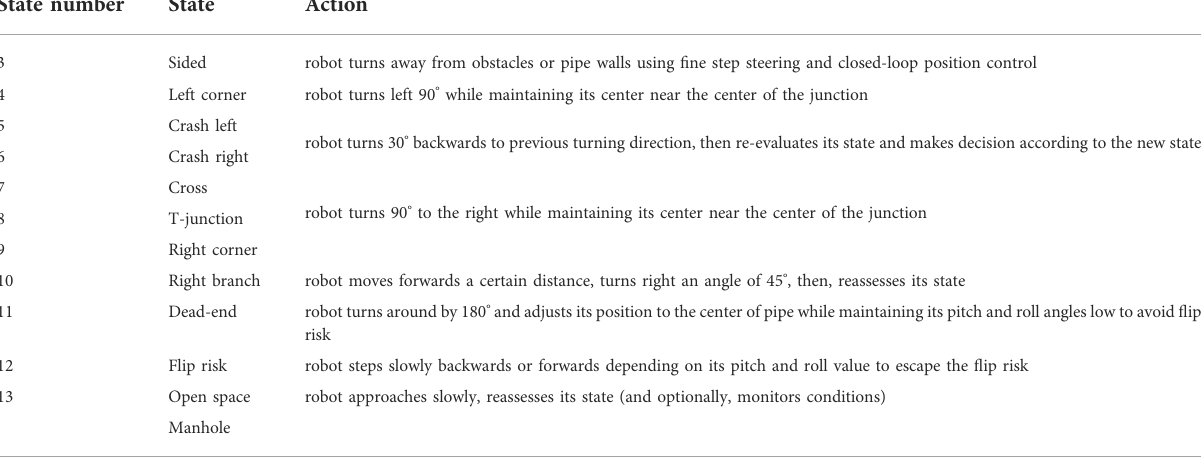
TABLE 1 High level control actions following state